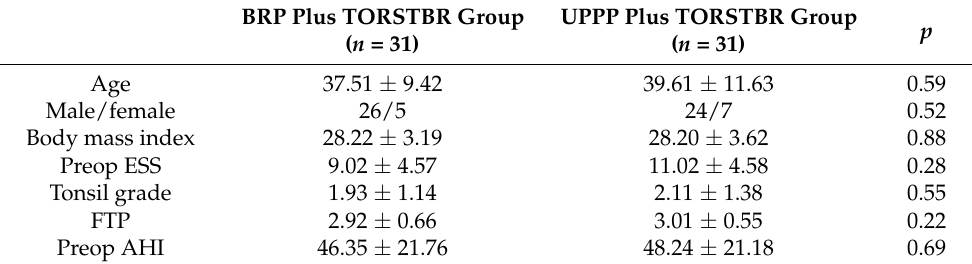
Table 1. Demographic data of the two groups.